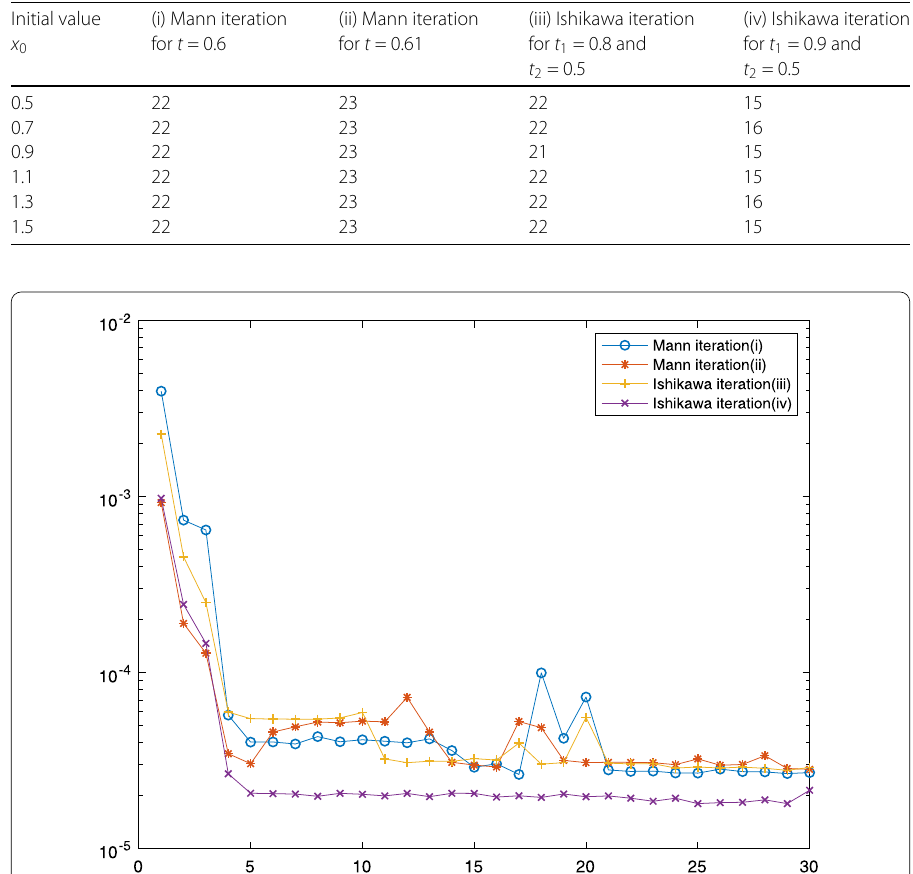
Figure 1 CPU time for Mann iterations and Ishikawa iterations with x 0 =